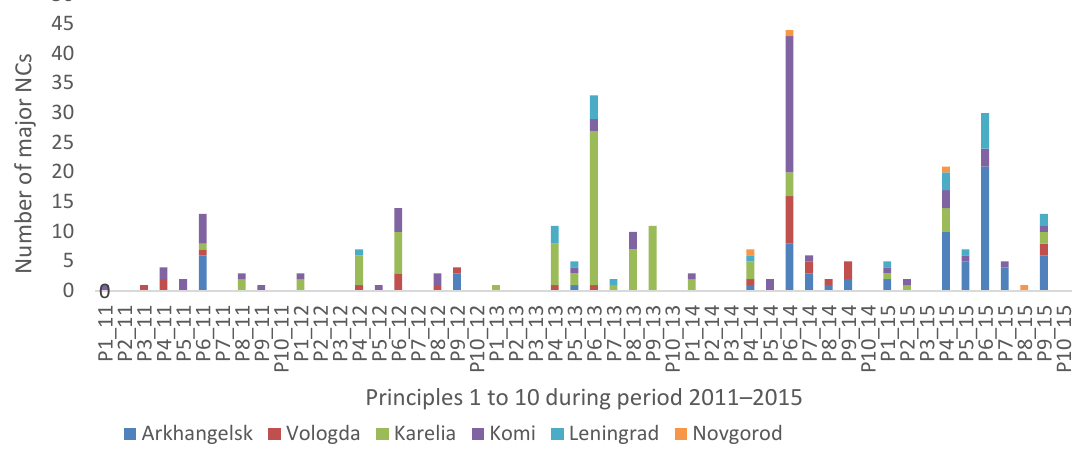
Figure 3. Distribution of major non-conformities (NCs) among the regions during 2011–2015.